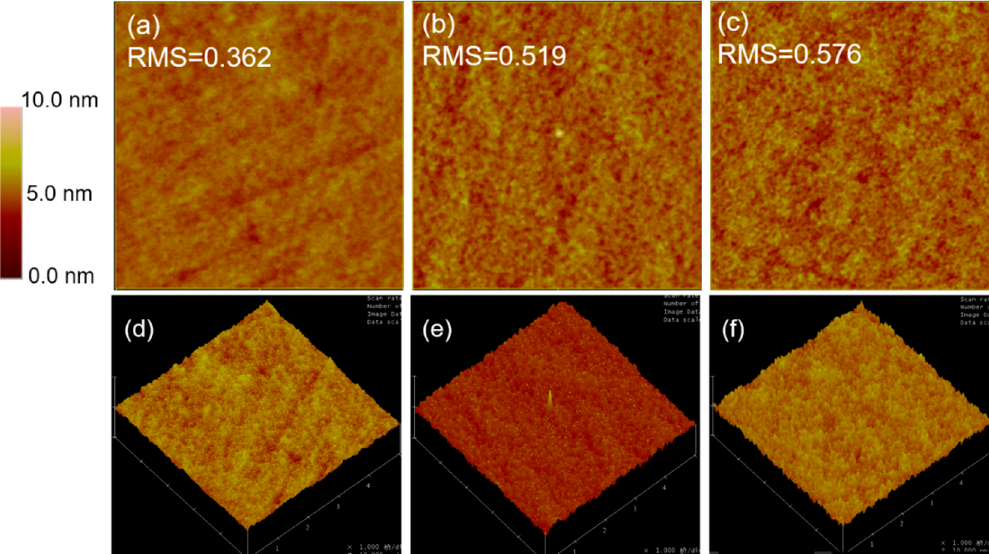
Figure 3. The atomic force microscope (AFM) height images and 3D images of ( a , d ) control binary film; ( b , e ) ternary blend film with 70% PCDTBT; ( c , f ) ternary blend film with 100% PCDTBT. The scan size of all images is 5 × 5 μ m.